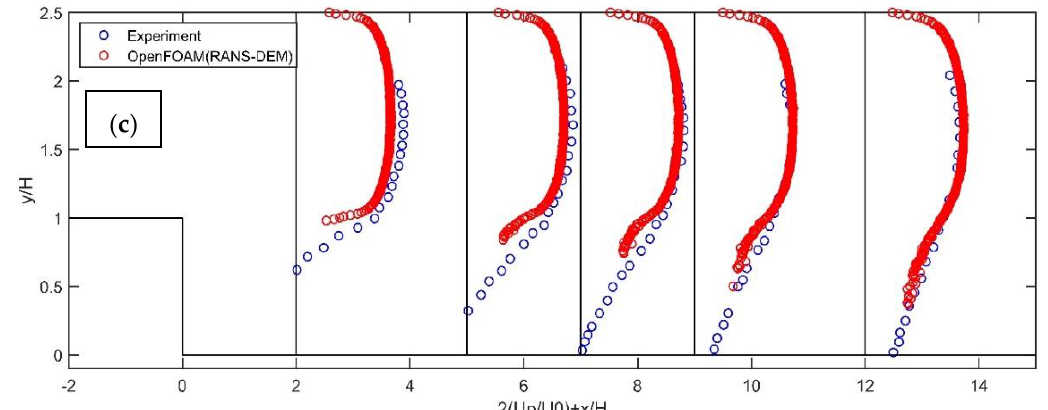
Figure 7. Comparisons of experimental and OpenFOAM simulated average streamwise particle velocity profiles at the measurement locations for one-way coupling and 10% mass loading of copper particles under RANS-DEM framework. ( a ) Particle injection velocity as (10.5, 0, 0) m/s, ( b ) particle injection velocity same as that of the fluid velocity profile at inlet, ( c ) particle injection velocity as (0, 0, 0) m/s.